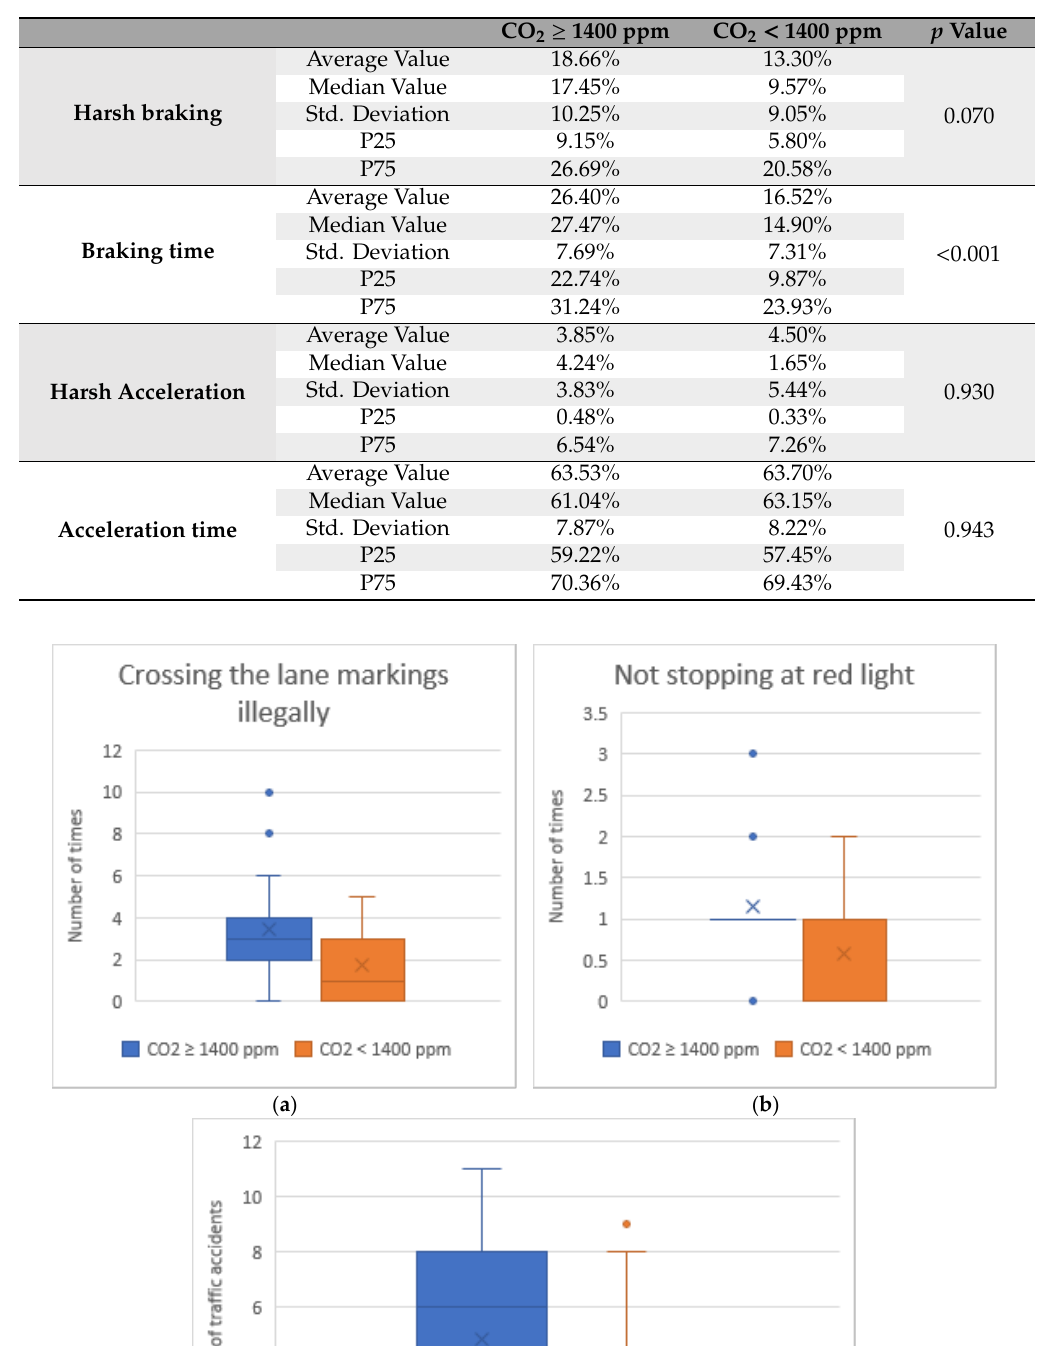
Table 13. Driving behavior grouped by CO 2 level.